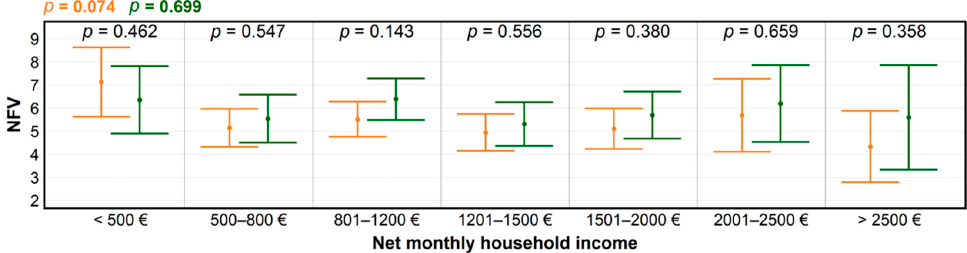
Figure 4. Levels of significance for differences in numbers of forest visits (NFV) among groups created according to net monthly household income, before (orange) and during the COVID-19 pandemic (green), produced using ANOVA; and for within-group NFV differences (black), determined by t -test.